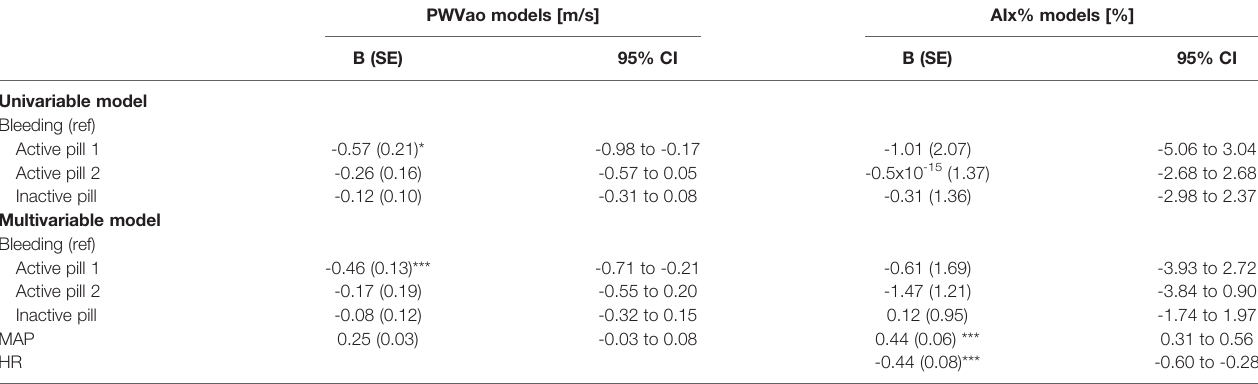
TABLE 6 | Association of pill cycle stages with arterial stiffness.